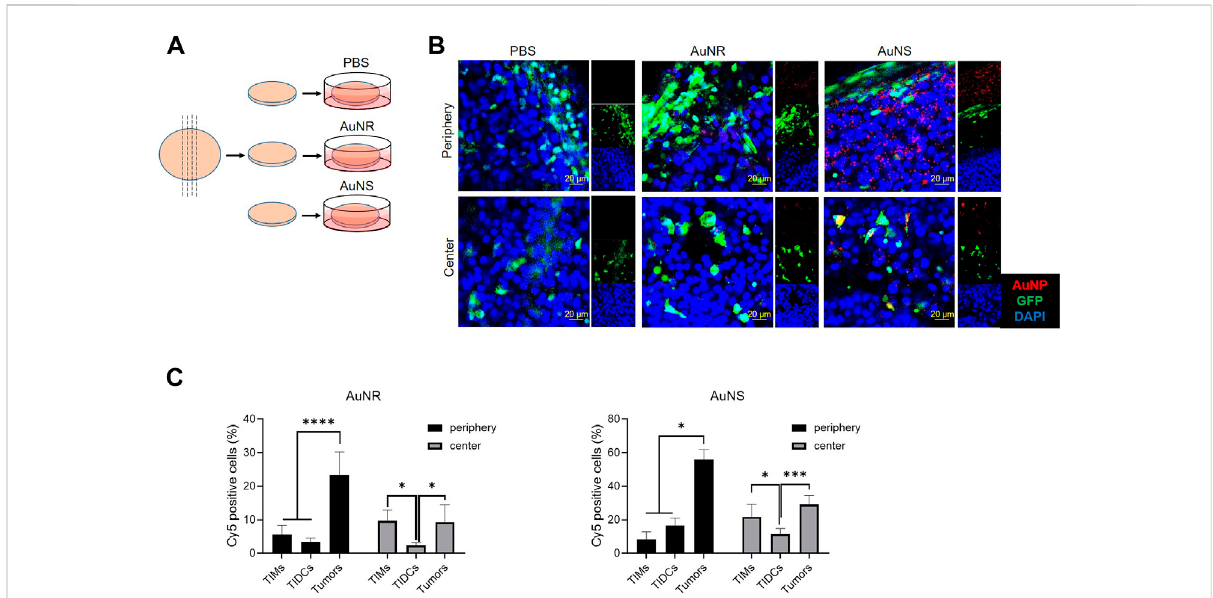
FIGURE 5 The vibratome sectionsof tumor can beused to evaluate the distributions of AuNR and AuNS inthetumor exvivo . (A) Schematicillustrations of vibratome tissue section and ex vivo AuNP upake. The B16 tumor cells were subcutaneously implanted into GFP transgenic mice 14 days before the tumor was harvested. Afterwards, 200 μ m-thick tumor vibratome sections were obtained and then incubated with PBS, Cy5-AuNR, or Cy5-AuNS at 37 ° C for 2 h (B) CLSM images of fl uorescence signal in the tumor vibratome sections which was indicated in (A) . (C) Fluorescence signal in the tumor vibratome sections by fl ow cytometry. Cellular uptake of Cy5-AuNR and Cy5-AuNS by TIMs, TIDCs or tumor cells in the periphery or center region in B16 tumors of GFP mice measured by fl ow cytometry. Cy5 labeled AuNPs (red) were accumulated in the vibratome tumor sections of B16 tumor bearing GFP (green) mice. Cell nuclei were stained with DAPI (blue). The scale bar is 20 μ